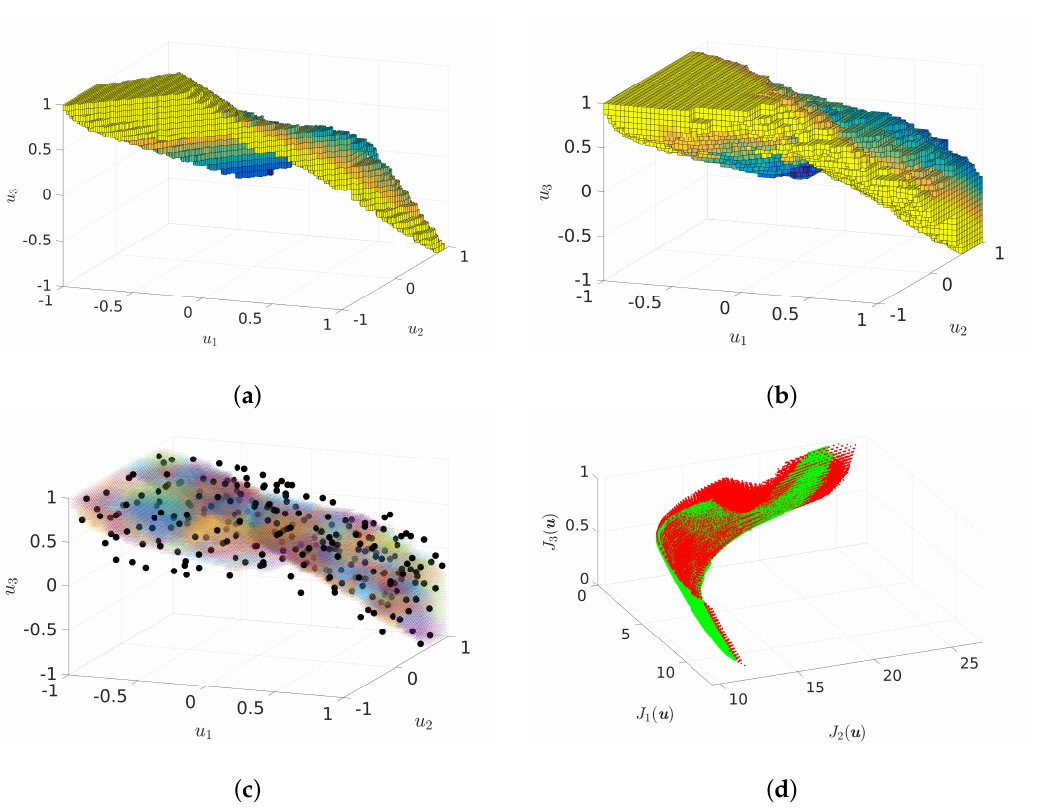
Figure 8. ( a ) Pareto set of a semilinear heat flow MOP with four controls (coloring according to u 4 ), solved directly including an FEM model in the subdivision algorithm. ( b ) Pareto set of the same problem, solved with localized ROMs. ( c ) The reference controls for which the local ROMs have been computed are shown in black, and the colored dots are sample points at which the objective function was evaluated. The colorings denote assignments to a specific ROM. ( d ) The corresponding Pareto fronts, where the FEM solution is shown in green and the ROM solution in